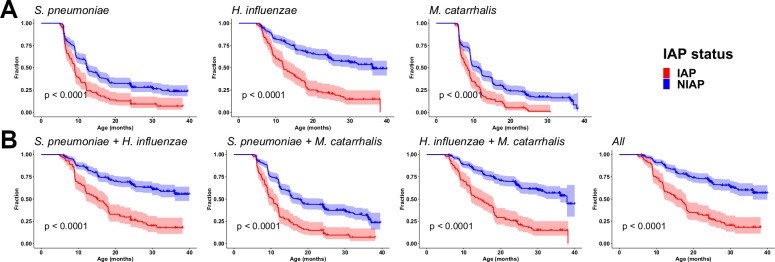
Pathobiont colonization in IAP and NIAP children.A) The age at first colonization with S. pneumoniae, H. influenzae and/or M. catarrhalis as microbiologically identified in child NP samples from 6 to 40 months of age are shown (n = 98 IAP, 256 NIAP). The proportion of colonization-negative children throughout the time course are represented as the surviving cohort in the analysis. B) Age at first colonization with combinations of pathobionts as shown. p values from log-rank test are displayed on each graph.